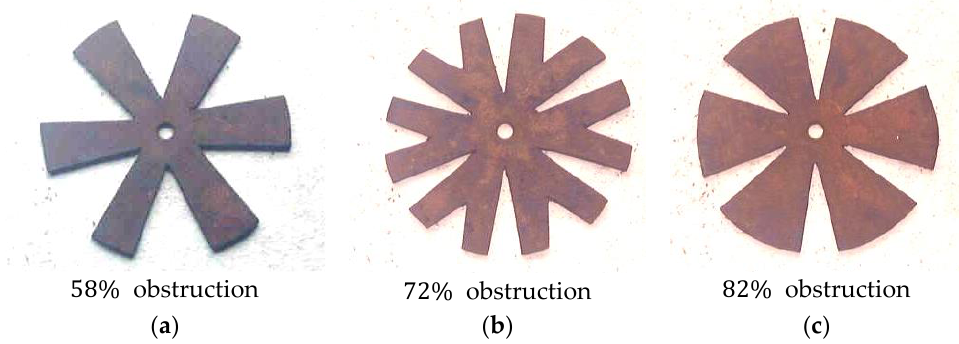
Figure 10. Mechanical resistances R1 ( a ), R2 ( b ), and R3 ( c ) were used in the tests with obstruction. For flow and stream velocity measurements, two NAVICO-CORUS TXD300 paddle-